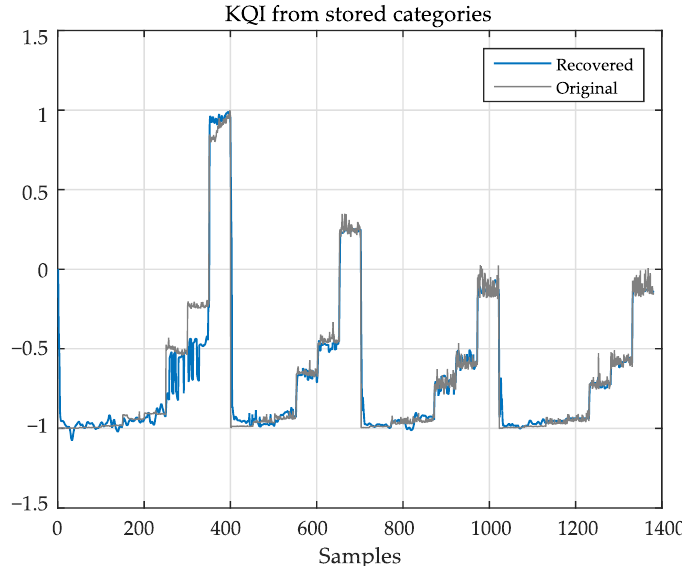
oper . Black: original data; blue: recovered KQI. Compare w P } {